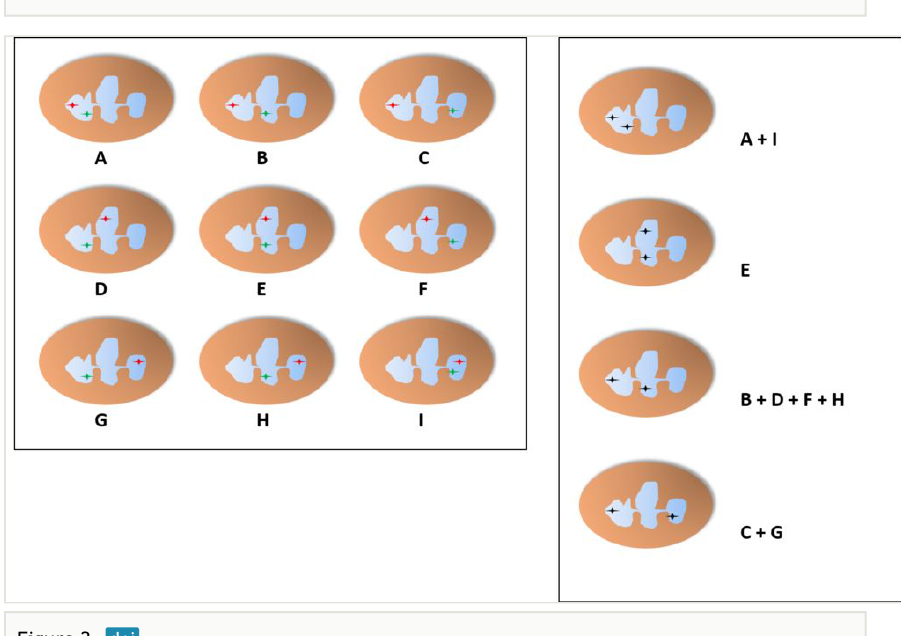
Figure 1. Possible distributions of both copies of a gene in a basophil or eosinophil (left) and how we would perceive them through the microscope (right).